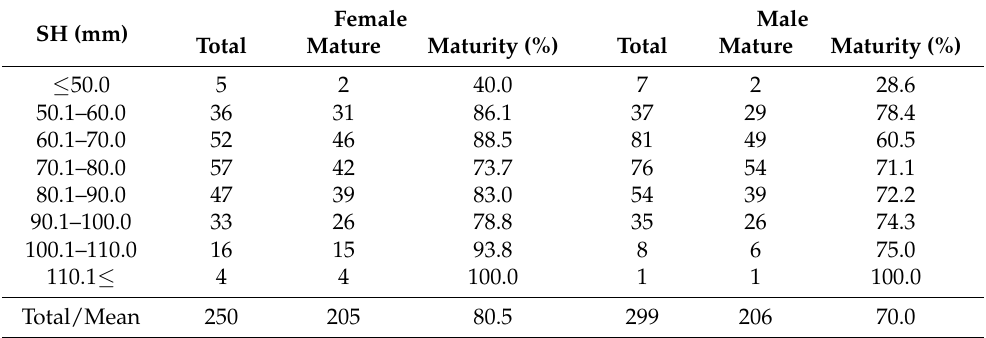
Table 2. Sexual group maturity with shell height (SH) of Buccinum osagawai